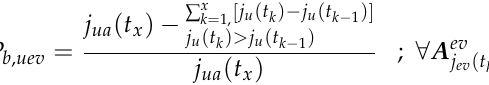
and A q at UEV j ev ( t k ) j q ( t k )